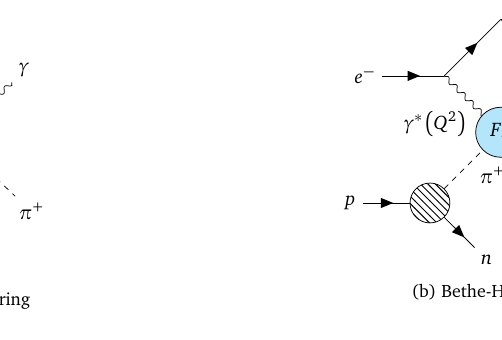
Figure 1: Feynman diagrams for the two contributions to the Sullivan process in the one-pion-exchange